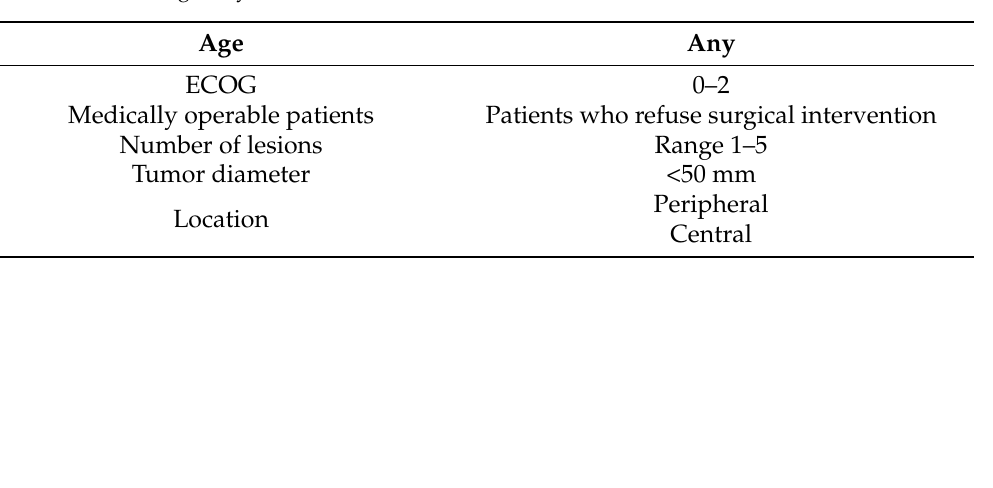
Table 1. Patient eligibility criteria for